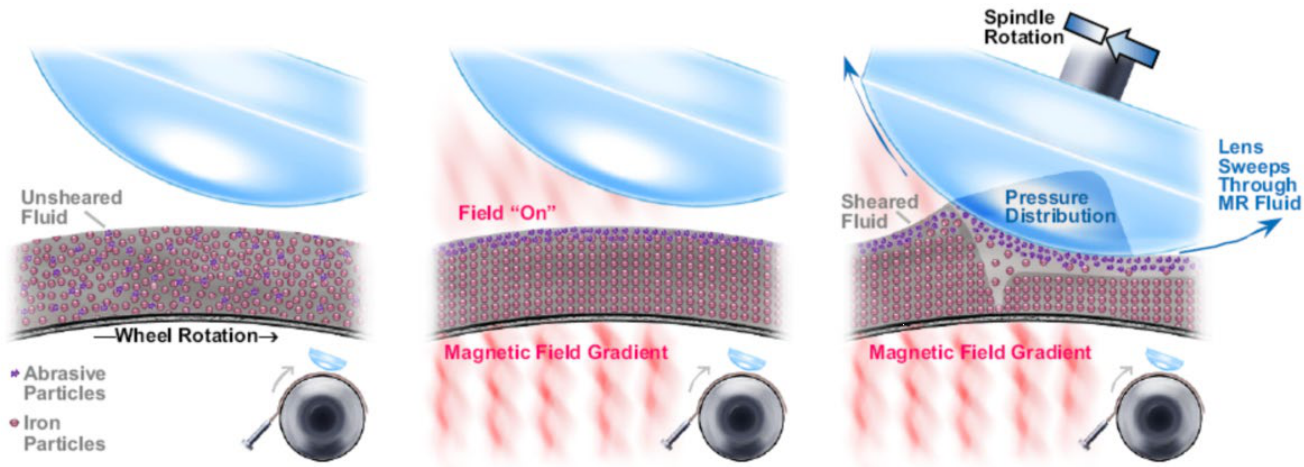
Figure 5. Schematic diagram of magnetorheological polishing principle.